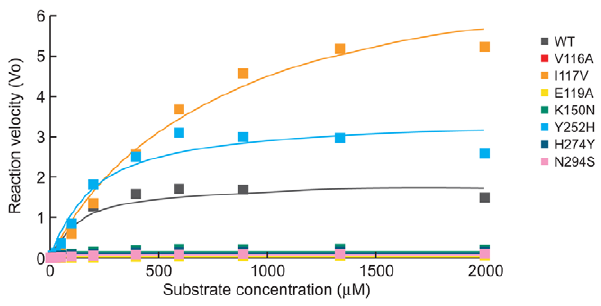
Figure 2. NA enzyme kinetics of the recombinant A/Turkey/15/ 06-like (H5N1) viruses. Substrate conversion velocity (V 0 ) of NA is shown as a function of substrate concentration. Fluorogenic MUNANA substrate was used at a final concentration of 0 to 2000 m M. The viruses were standardized to an equivalent dose of 10 7.5 PFU/ml. Fluorescence was measured every 92 sec for 45 min at 37 u C, using excitation and emission wavelengths of 355 and 460 nm, respectively.